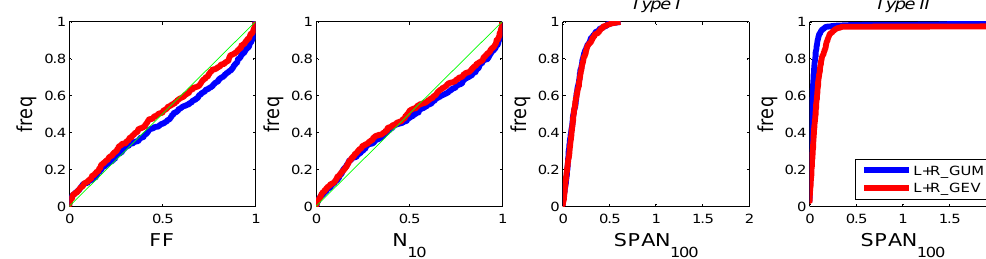
Fig. 5. Reliability ( FF , N 10 ) and stability (SPAN 100 – type I, SPAN 100 – type II) indices for local-regional implementations.